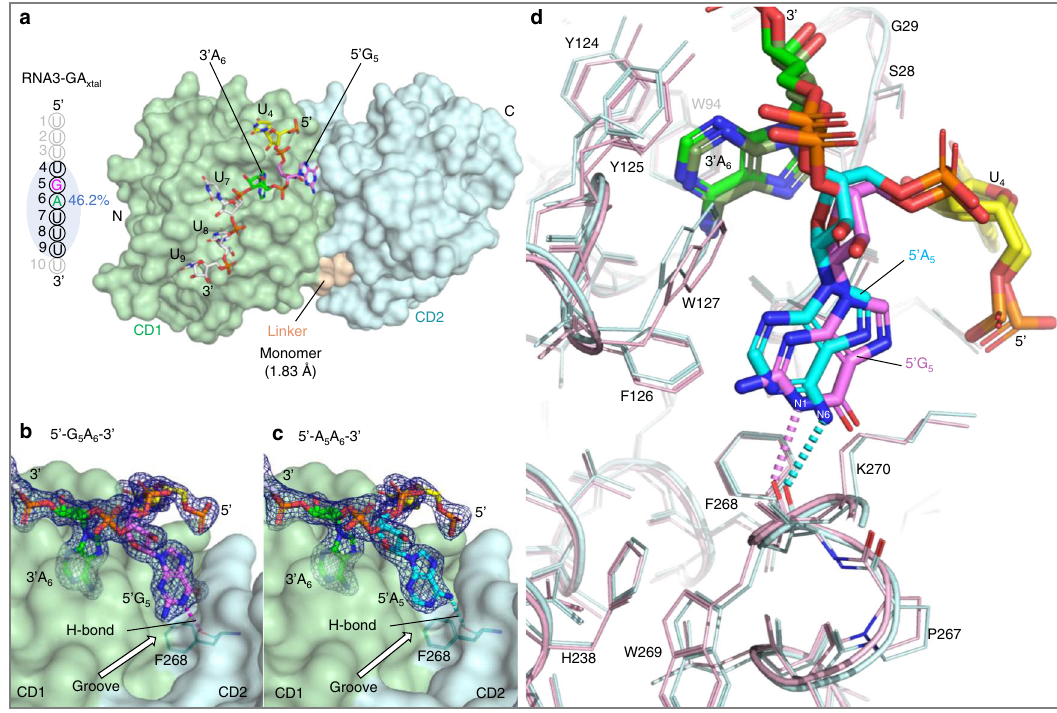
Fig. 5 | Co-crystal structure of RNA3-GA xtal in complex with rA3G R8/E259A (PDB ID: 8EDJ) and comparison of the sequence motifs 5 ′ -G 5 A 6 -3 ′ and 5 ′ -A 5 A 6 -3 ′ bound to the pocket and the groove on the rA3G surface. a RNA3-GA xtal and its co-crystalstructurewithrA3G R8/E259A asamonomer.RNAbasesnotmarkedinlight gray are resolved. The sequence motif 5 ′ -G 5 A 6 -3 ′ iscolored as 5 ′ G 5 in pink and 3 ′ A 6 in green. The percentage of the buried RNA surface is indicated. The CD1 (pale green),theCD2(palecyan),andthelinker 194 RHL 196 (wheat)arelabeled. b A2Fo-Fc electron density map of the sequence motif 5 ′ -G 5 A 6 -3 ′ , showing 5 ′ G 5 (pink) inside the groove and 3 ′ A 6 (green) inside the pocket (contoured at 1.5 σ level). The hydrogenbond(H-bond)betweenN1of5 ′ G 5 andthemain-chaincarbonylgroupof